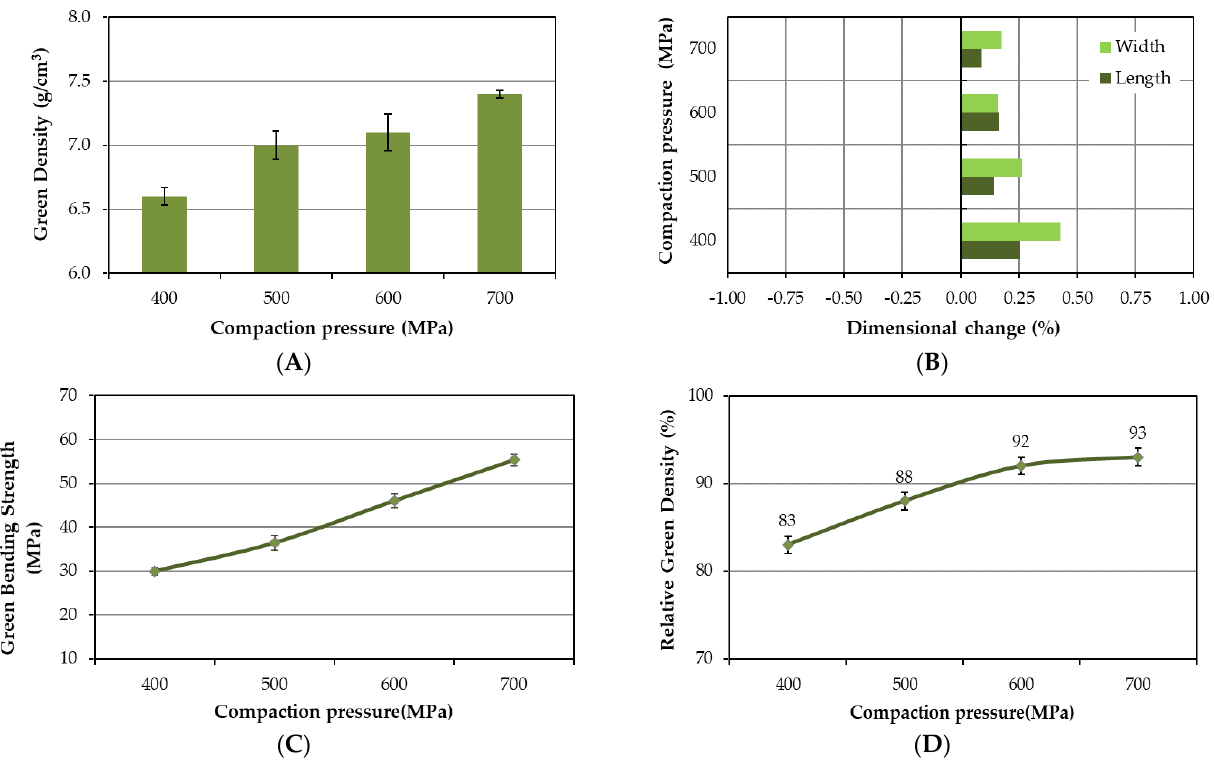
Figure 6. Variation of green properties with compaction pressure: ( A ) density, ( B ) dimensional variation, ( C ) bending strength, and ( D ) relative green